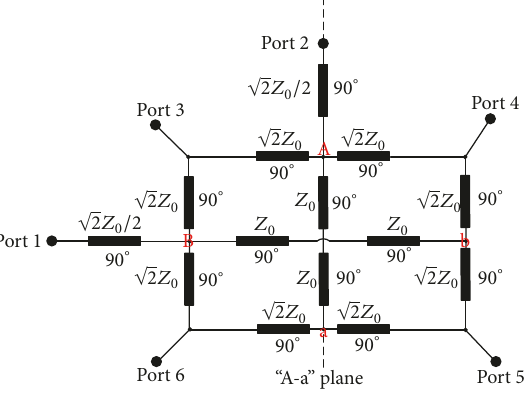
Figure 2: Equivalent structure of the hybrid feeding network.